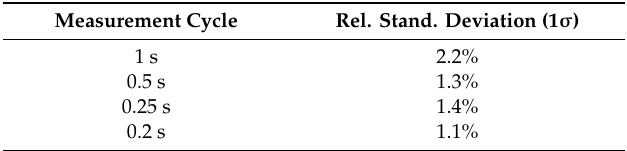
Table 3. Relative standard deviations (1 σ ) for various measurement cycles of setup F. The values are determined from a single measurement position for an electrode layout of L / 2 = 10